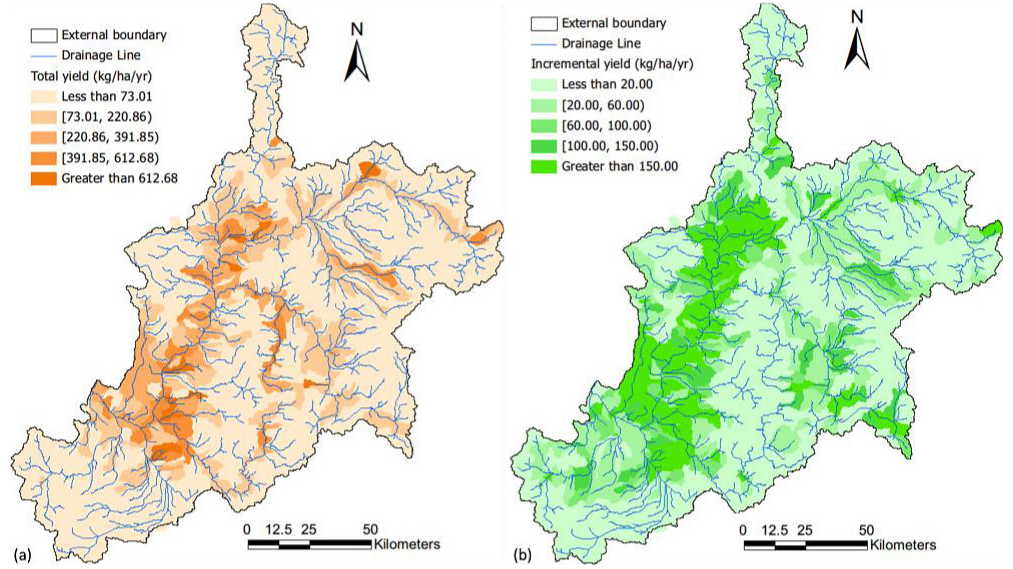
Figure 8. Map showing the spatial distribution of total suspended sediment yields (a) and incremental suspended sediment yields (b) esti- mated by